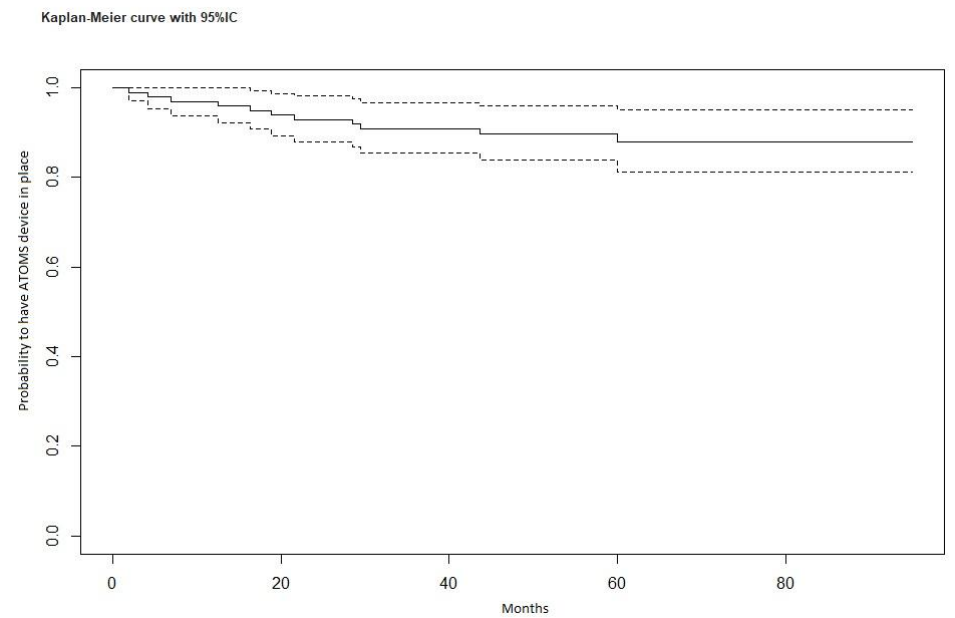
Figure 2. Survival of the device, Kaplan–Meier curve with 95% confidence interval. Table 3. Continence